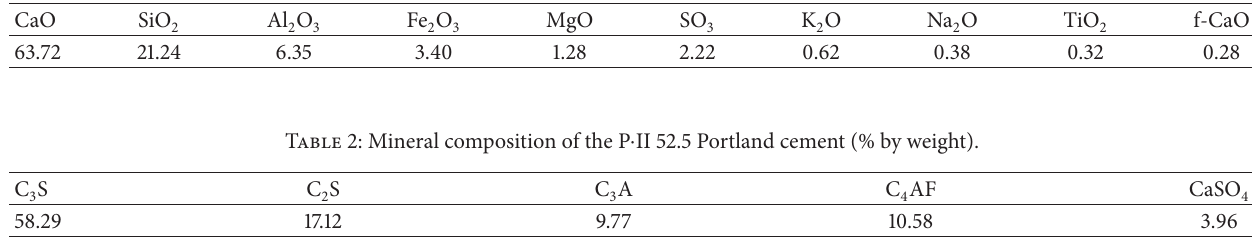
Table 1: Chemical composition of the P ⋅ II 52.5 Portland cement (% by weight).